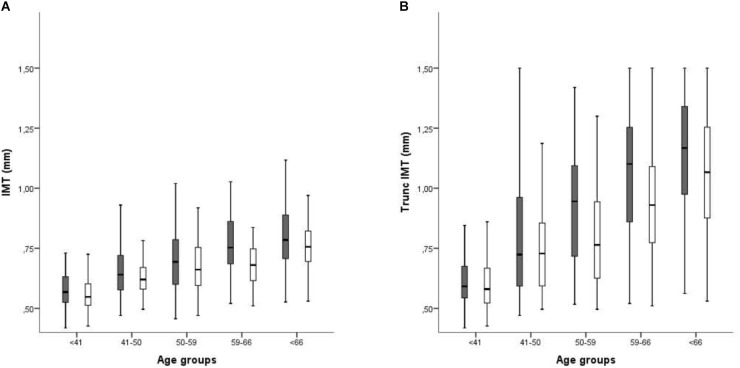
Averaged intima media thickness in carotid arterial territories stratified by age and sex. Dark bars: Males; White bars: Females. (A) Excluding territories with atheroma plaque; (B) Including territories with atheroma plaque. In territories with plaque, the IMT value was truncated to 1,5 mm. p trend > 0,01.